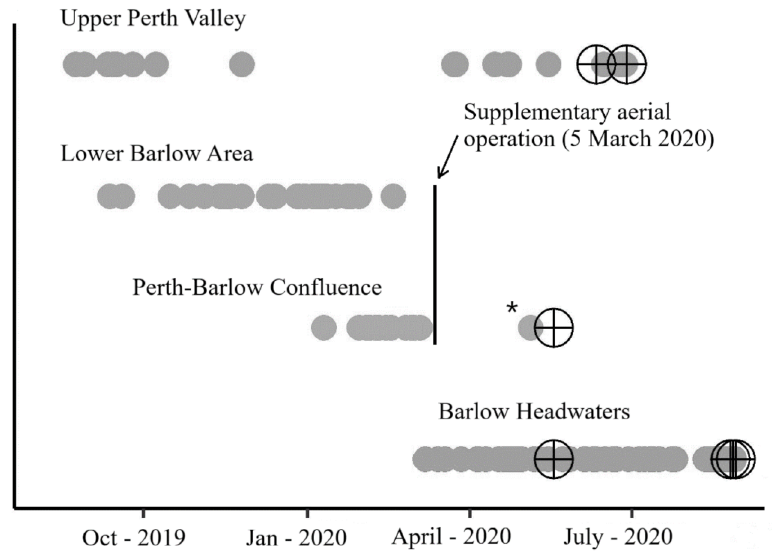
Figure 3. Possum detections by area over time. Crossed circles represent kills. * The Perth-Barlow confluence possum detection represented on the figure after the supplementary aerial operation was a possum scat, and the body found near the same location is believed to have died from that toxin operation.